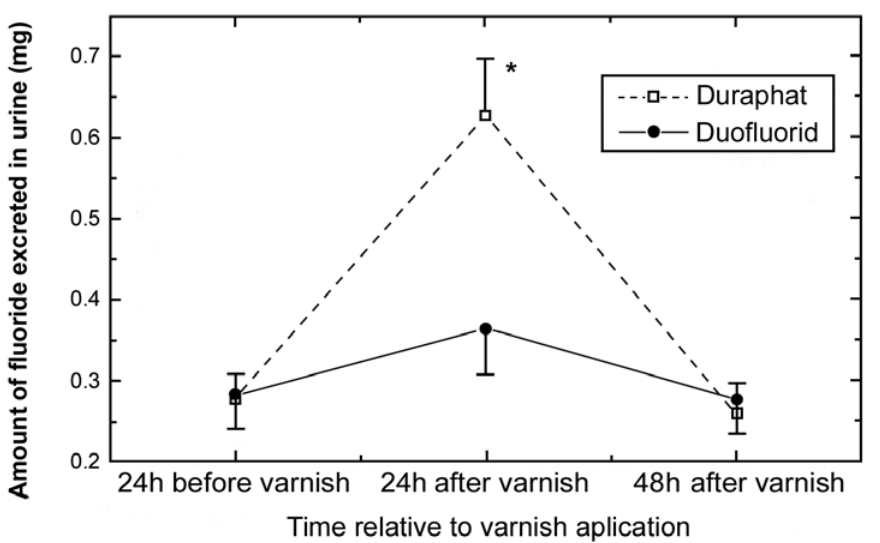
FIGURE 1- Means of the amount of fluoride excreted in urine before varnishes application, and after 24 h and 48 h. Bars indicate standard error of means. * shows a significant difference from the other values (two-way repeated measures ANOVA, p<0.05)